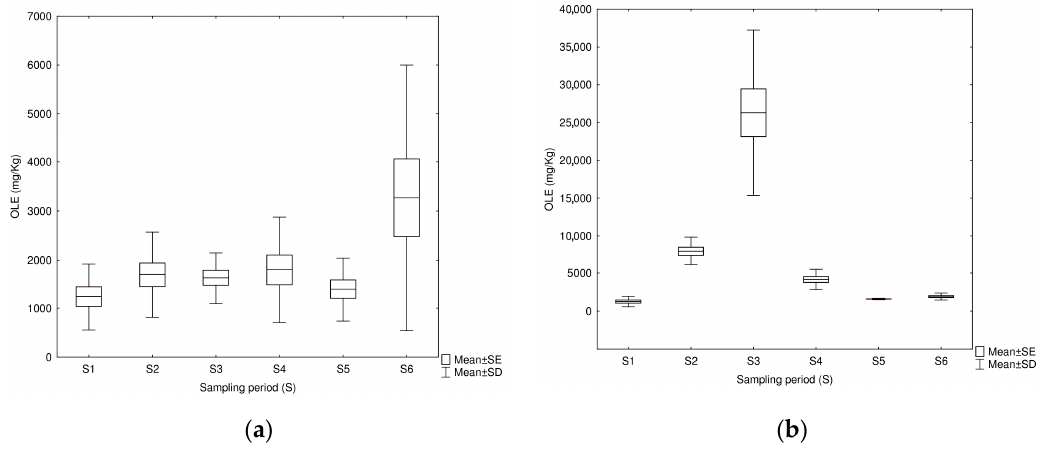
Figure 4. Mean value ± standard error (SE) and mean value ± standard deviation (SD) representation for